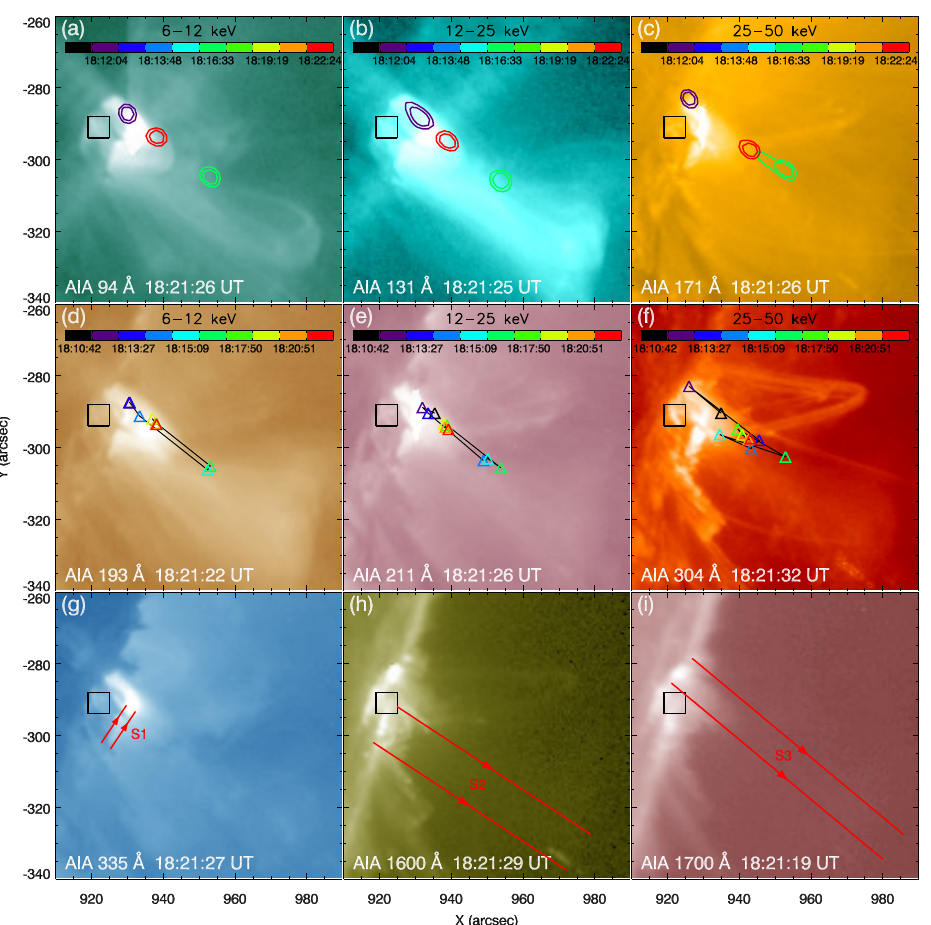
Figure 3. Flare images at nine wavelengths of SDO/AIA around 18:21 UT, they are 94 ˚A ( a ), 131 ˚A ( b ), 171 ˚A ( c ), 193 ˚A ( d ), 211 ˚A ( e ), 304 ˚A ( f ), 335 ˚A ( g ), 1600 ˚A ( h ), and 1700 ˚A ( i ). The contours and triangles represent the X-ray sources at 6–12 keV, 12–25 keV and 25–50 keV in different times (colorbar). Contour levels are 90% and 82% of the peak intensity. Three groups of red solid lines outlines the slit positions in Figures 7–9 and arrows indicate their Y-axes. The black box represents the region where we integrate AIA light curves in Figure 5.